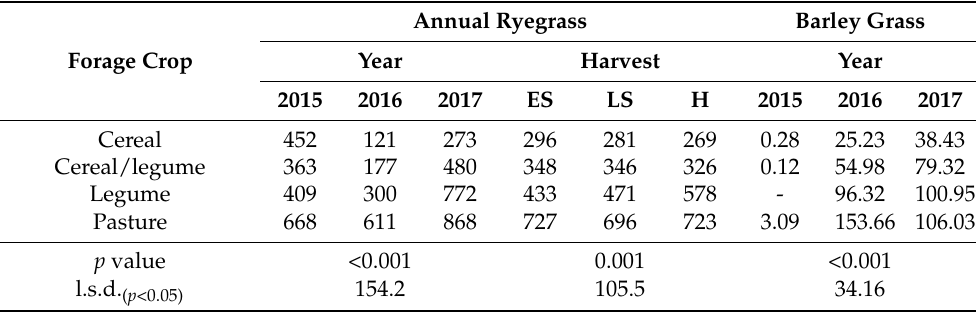
Table 5. Annual ryegrass and barley grass content (g/kg) of forage crops grown in 2015, 2016 and 2017, and forage harvested as early silage (ES), late silage (LS) or hay (H) at Wagga Wagga NSW (crop × year). Annual Ryegrass Barley Grass Forage Crop